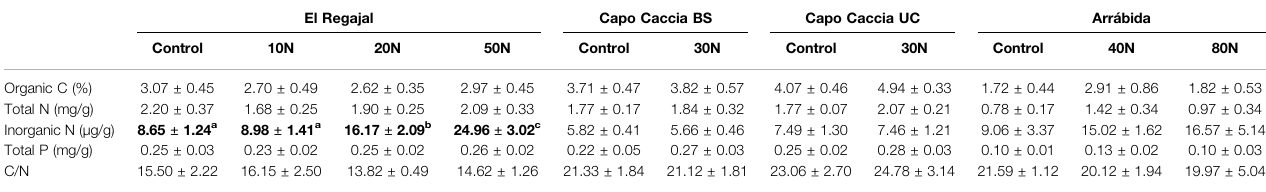
TABLE 3 | Soil chemical properties (means ± SE) in the top 8 cm of the soil pro fi le for each N treatment in El Regajal (Spain, n (cid:2) 6), Capo Caccia (Italy, n (cid:2) 4) and Arrábida (Portugal, n (cid:2) 3). Capo Caccia BS and Capo Caccia UC indicate bare soil and under canopy microsites, respectively. Statistical differences (one-way ANOVA, post hoc LSD test) are highlighted in bold and letters indicate signi fi cant differences ( p < 0.05) among N treatments within each